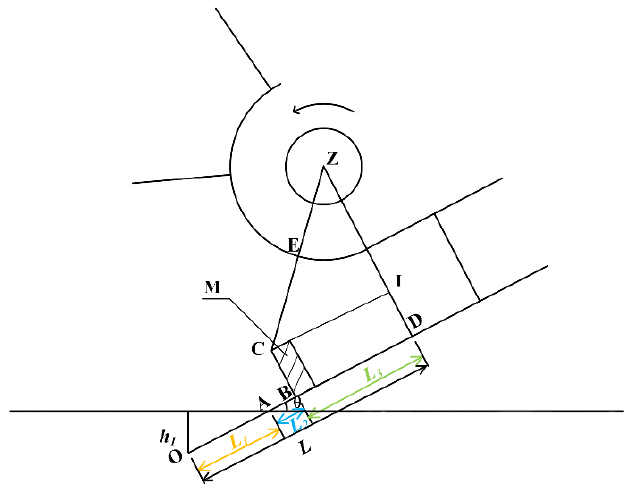
Figure 5. Schematic diagram of the mixture of dates and soil being shoveled up and climbed by the CT of the soil touching part of the picking device.